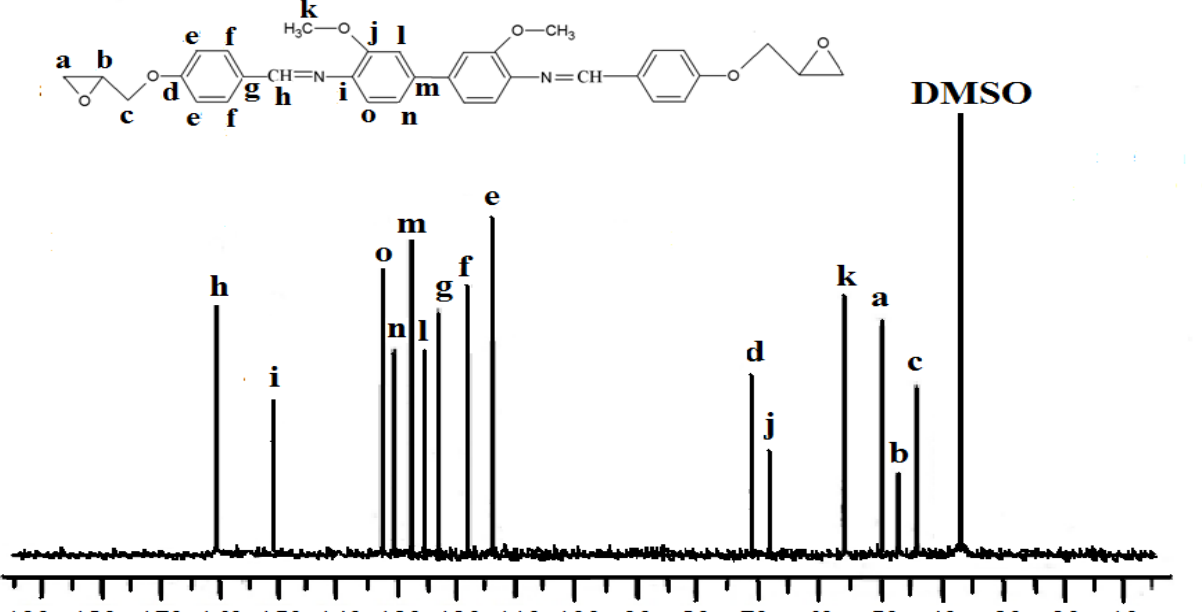
Figure 3. 13 C-NMR spectrum of IIa in